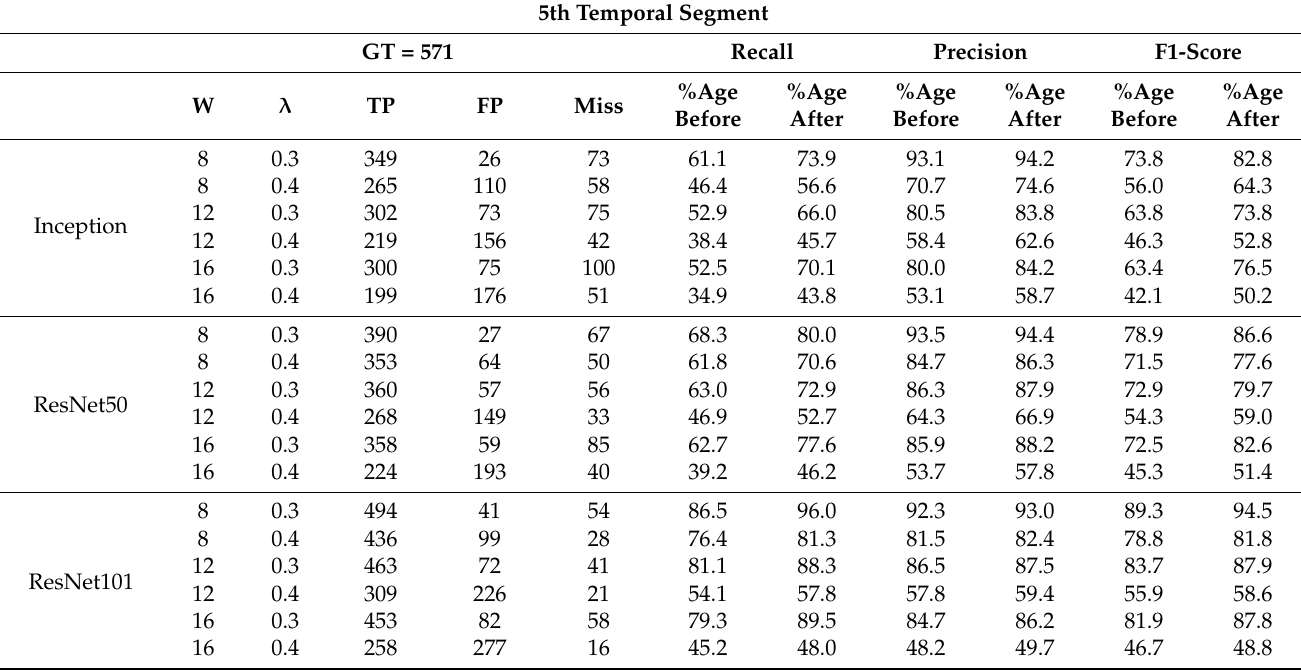
Table A6. Detections and refinement results of 5th temporal